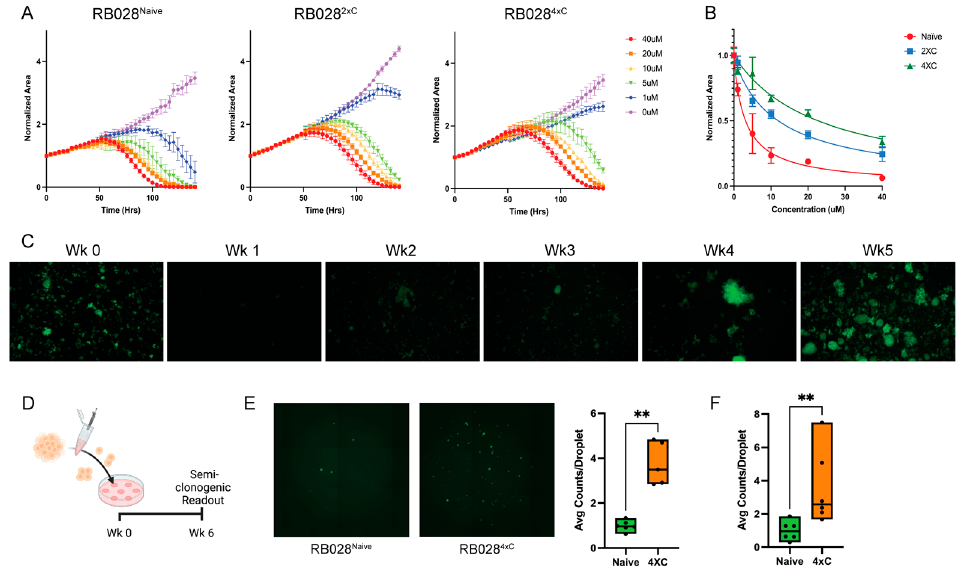
Figure 1. Sublethal carboplatin treatments induce chemoresistance in RB028 Naive . ( A ) Normalized viability of RB028 cell lines challenged with carboplatin, monitored over 7 days. ( B ) Representative kill curve at Hour 100 for carboplatin challenge demonstrates gain of chemoresistance (EC 50 for RB028 Naive ~3.15 μ M; EC 50 for RB028 2xC ~11.96 μ M; EC 50 for RB028 4xC ~22.73 μ M). ( C ) Recovery of RB028 Naive treated with 1 μ M carboplatin over five weeks. ( D ) Schematic of semi-clonogenic assay. ( E ) Representative images of RB028 Naive and RB028 4xC droplets at Week 6. Semi-clonogenic assay demonstrates higher average number of viable clusters per droplet for RB028 4xC at baseline and with 5 uM carboplatin (**, p < 0.01). ( F )